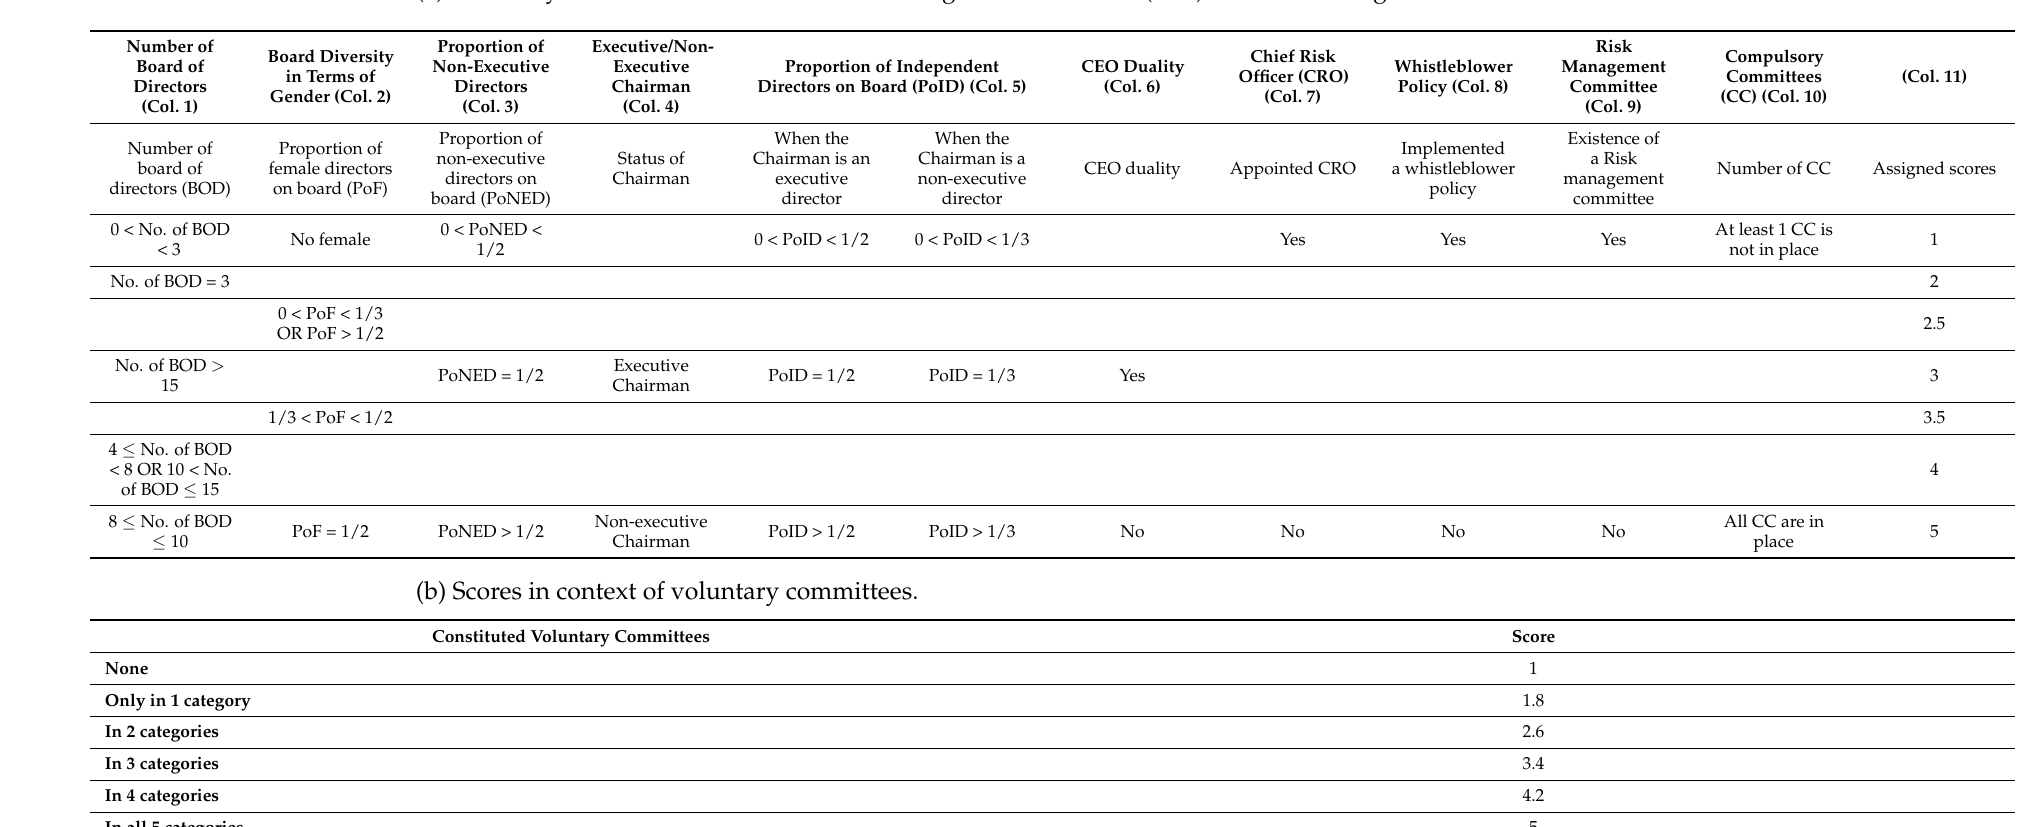
Table 2. ( a ) Summary of variables used to construct risk governance index (RGI) and scores assigned to them. ( b ). Scores in context of voluntary committees.